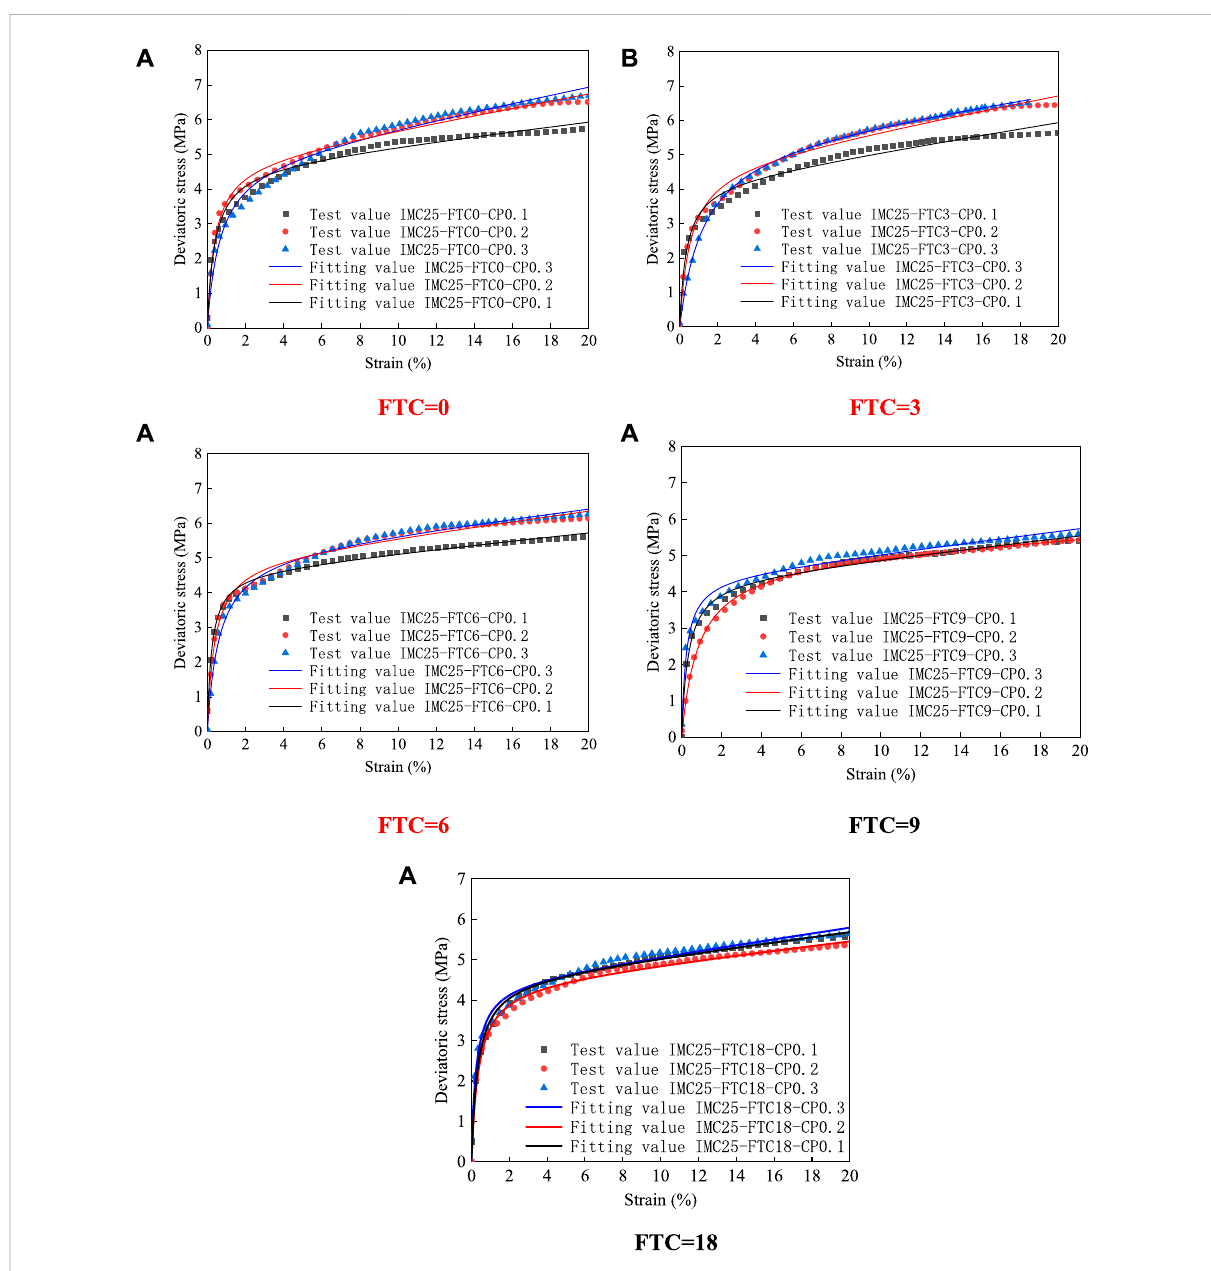
FIGURE 6 Comparison between the fi tting values of the formula and the test results for different con fi ning pressures: (A) FTC=9 (B) FTC=18. Note: Each working condition corresponds to other evaluation indexes (RMSE, MAE, MSE), which are given in the following comparative analysis of random forest model, frozen soil binary medium model, and PSO-LSTM